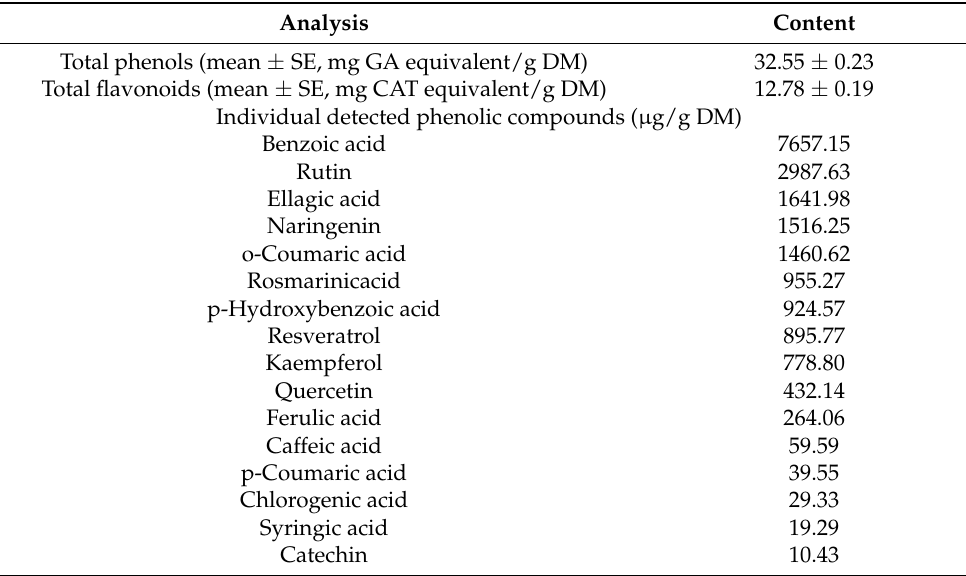
Table 1. Contents of the total phenolic, total flavonoid, and individual phenolic compounds (as de- tected by reverse-phase high-performance liquid chromatography; RP-HPLC) in the Cleome droserifolia (Forssk.) Del. methanolic extract (Cd